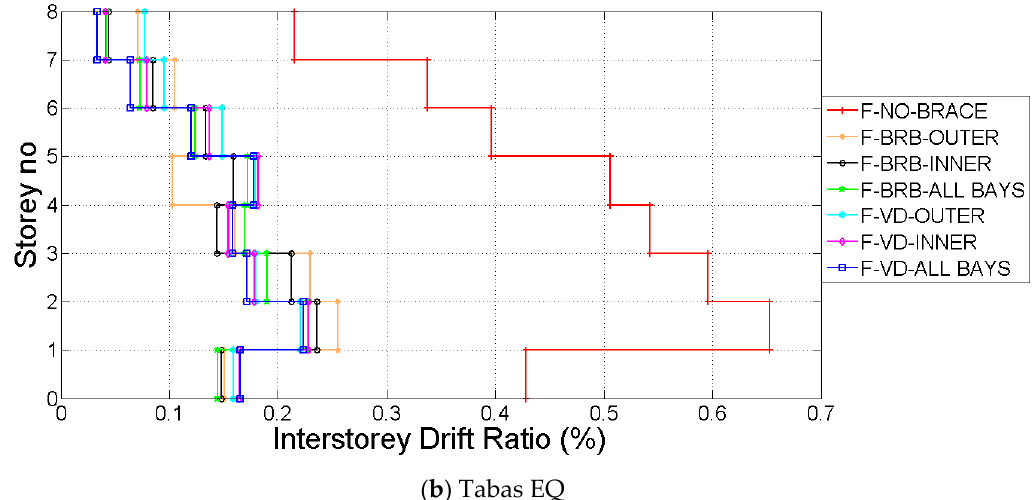
Figure 11. Variation of interstory drift ratio with story level in 8-story models.